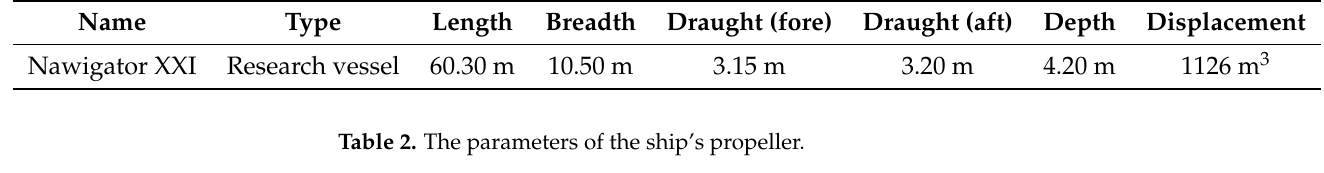
Table 1. The basic parameters of the ship.